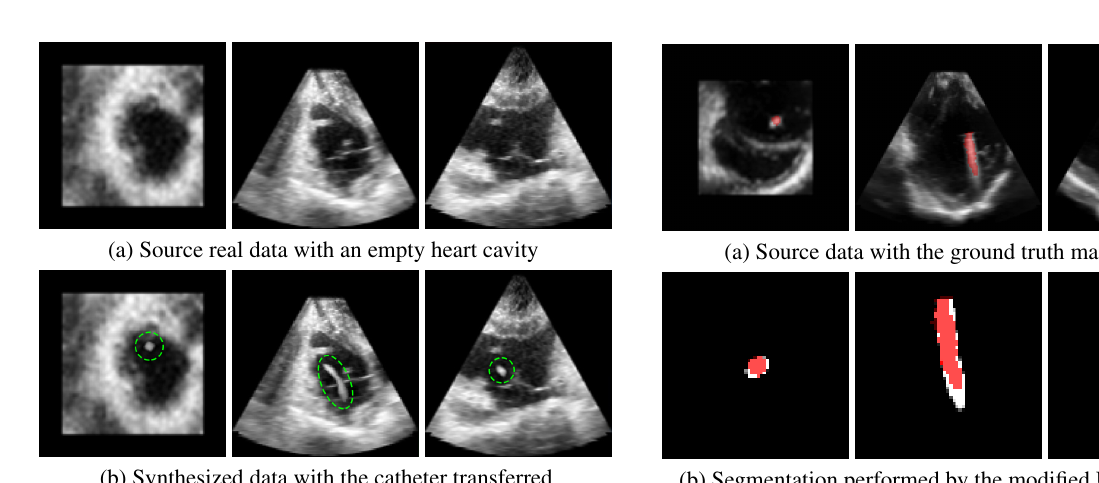
Figure 7. Segmentation of the catheter based on the dataset with RDR =